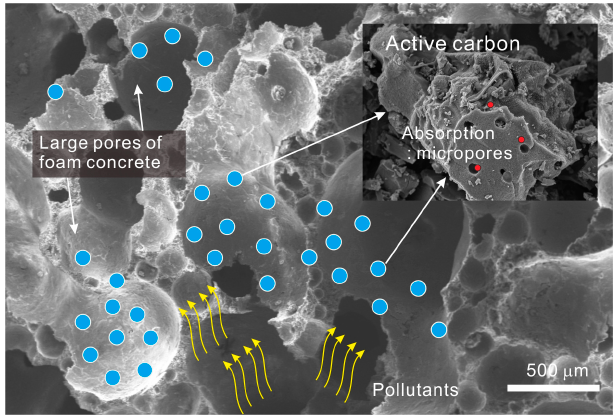
Figure 4. The concept of porous foam composite.